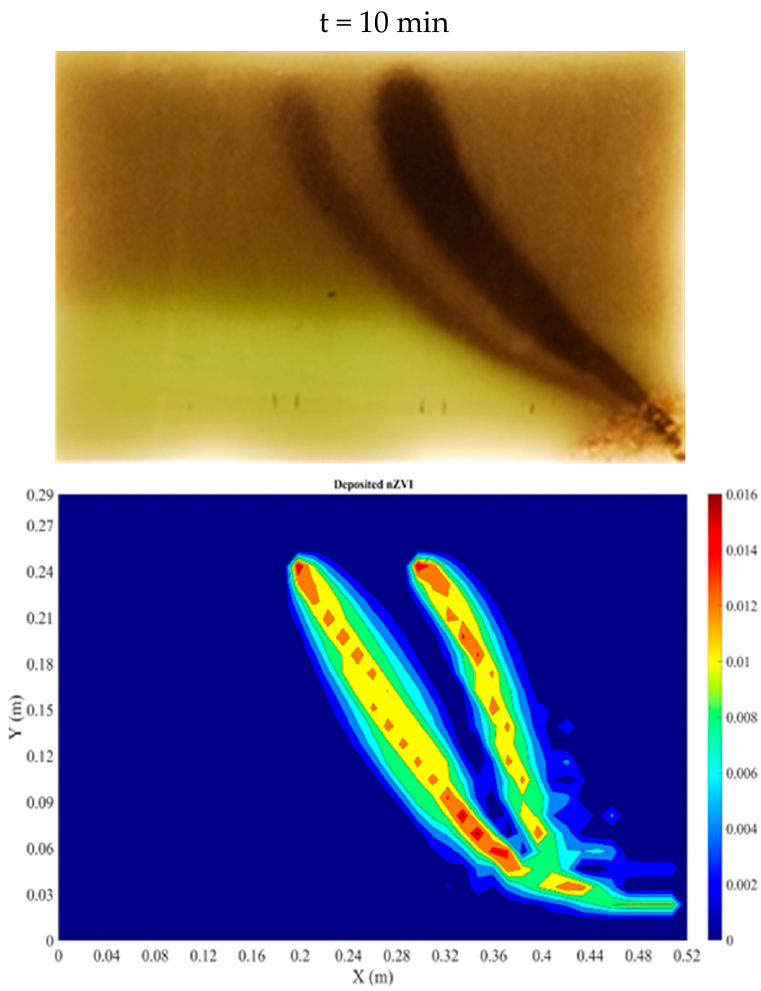
Figure 5. Results by numerical model simulations at 10 min (at the end of the permeation test) .